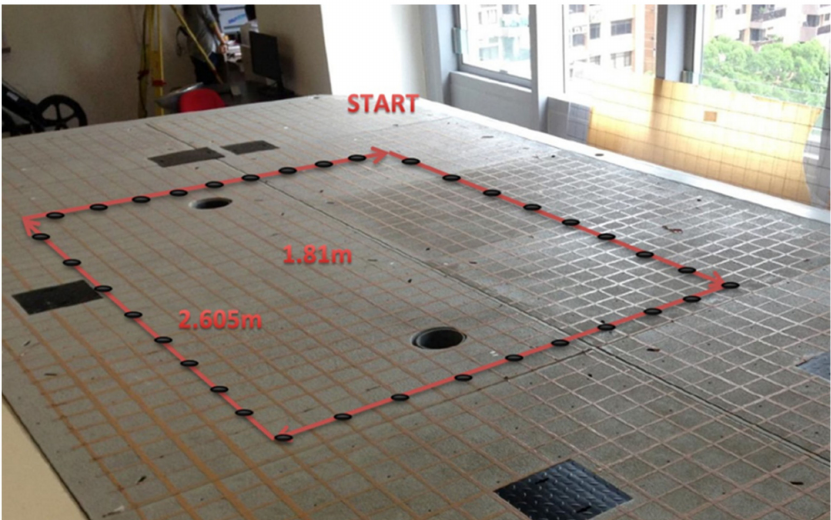
Figure 2. Photo of the large rectangle survey line. The black dots are ticks for 0.2 m intervals [15]. The trial started from the top right corner, and surveyed in a clockwise direction.